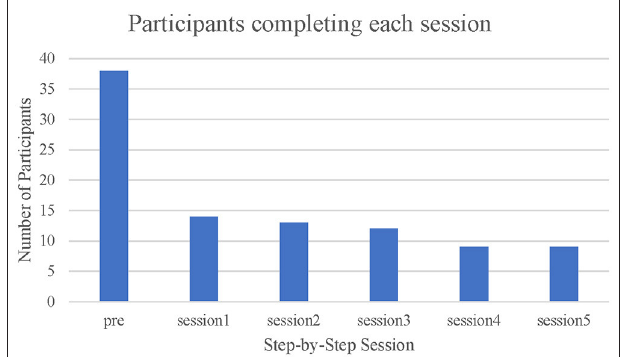
FIGURE 2 | Number of participants completing each